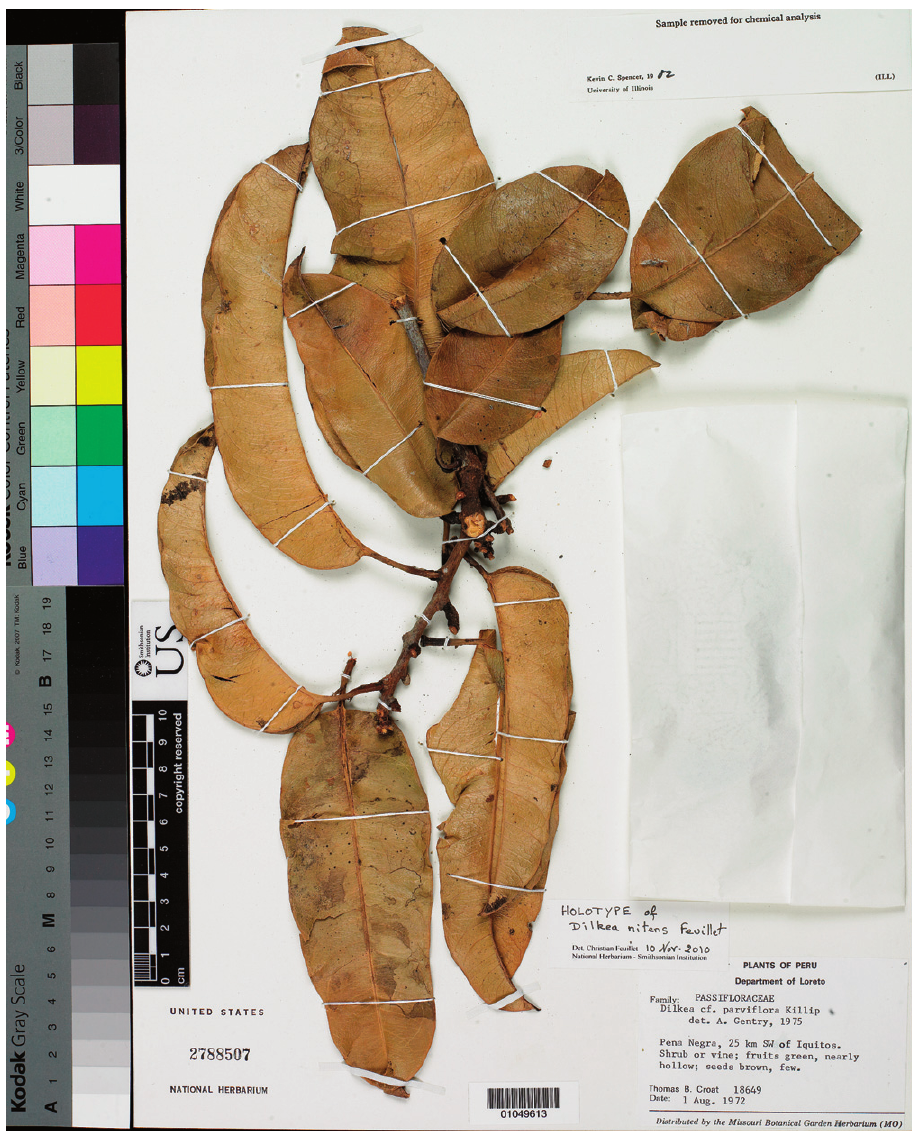
Figure 2. Holotype of Dilkea nitens Feuillet: T.B. Croat 18649 (US). Key to the species of Dilkea subg. Dilkea